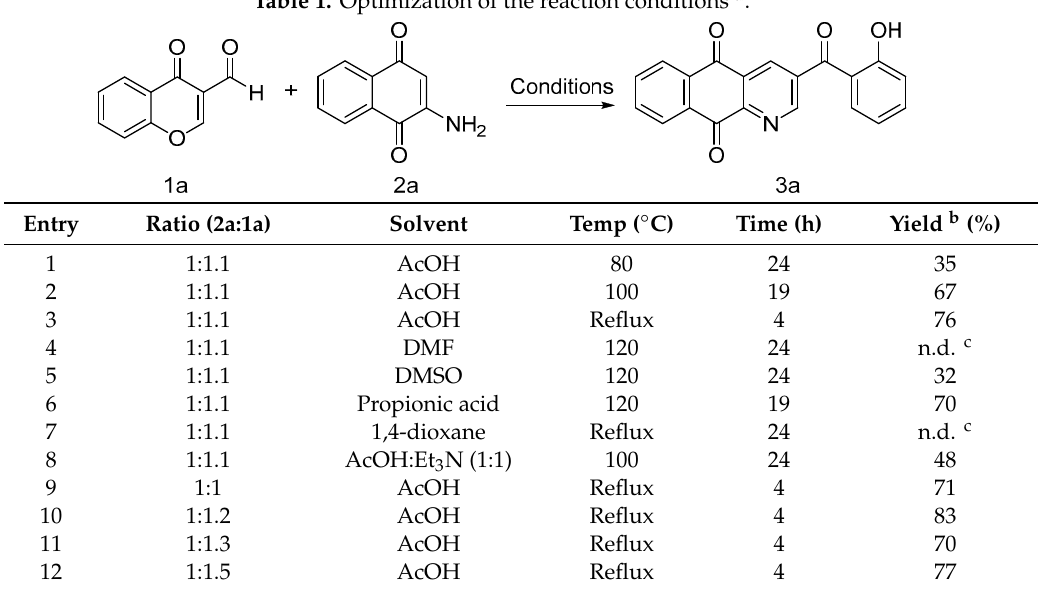
Table 1. Optimization of the reaction conditions a .